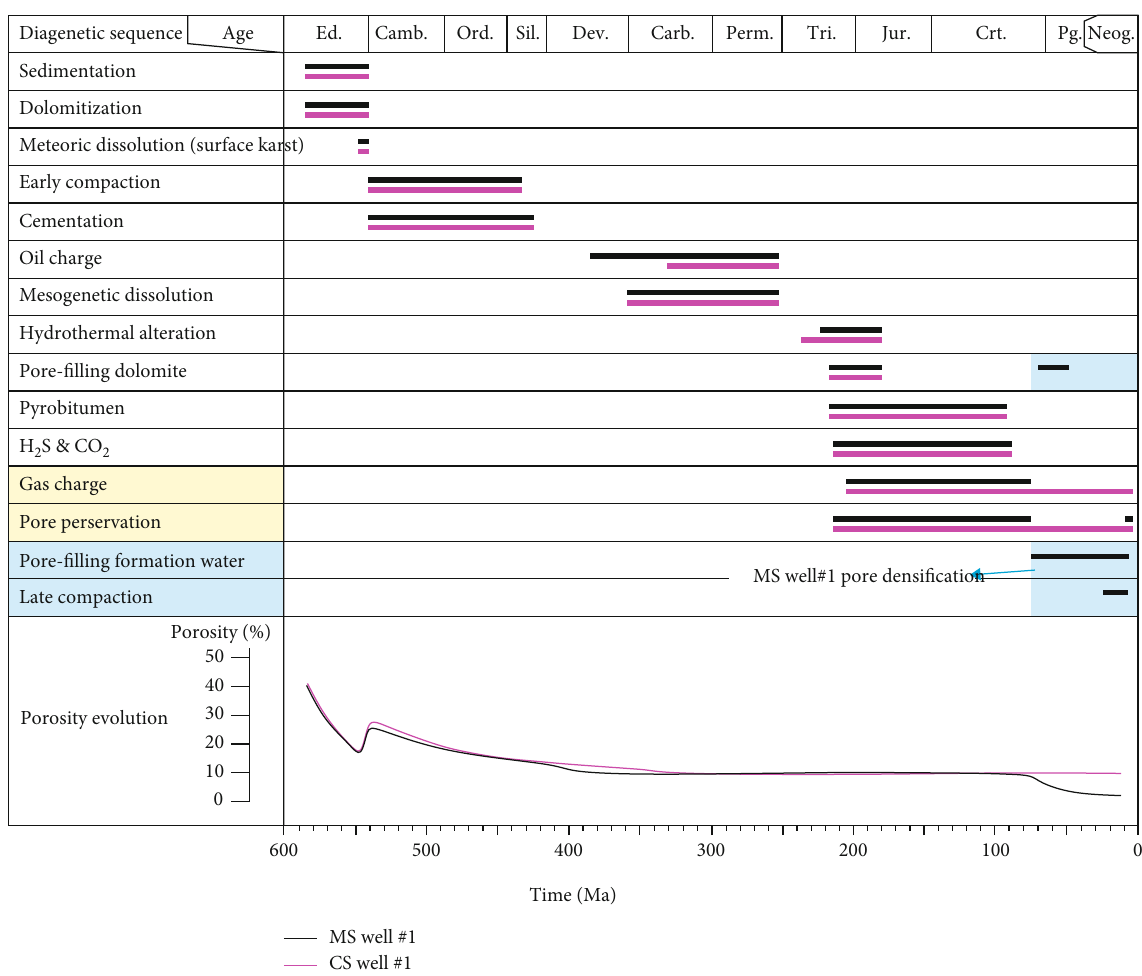
Figure 11: Diagenetic sequence and porosity development in the Sinian Z that di ff erential porosity evolution occurred in the Cenozoic between MS well #1 and CS well